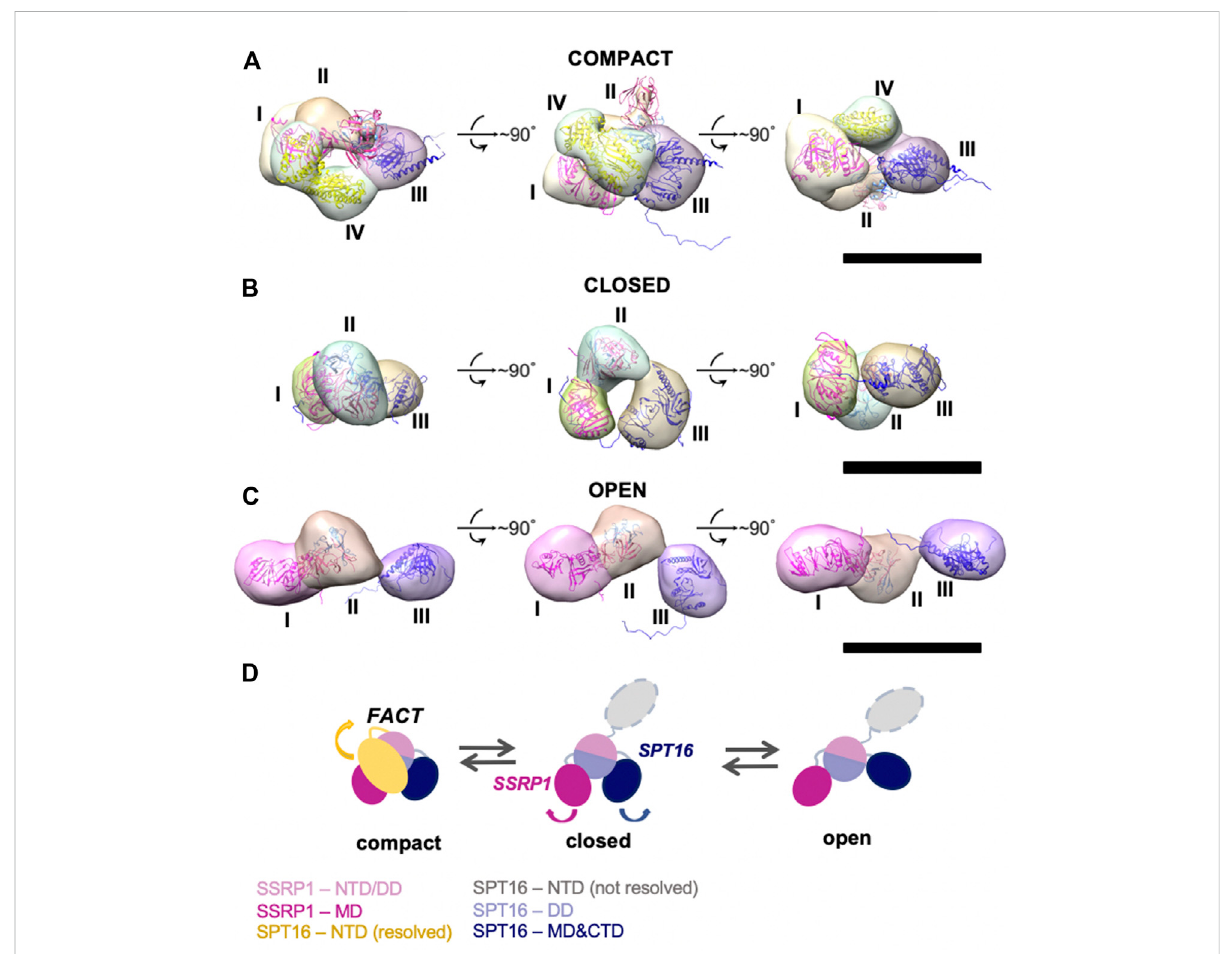
Three-dimensional reconstructions of FACT in compact, closed and open conformations. (A – C) 3D maps of FACT in the compact (A) , closed (B) and open (C) conformations. In the compact complex, the crystal structures of the domains were docked into corresponding EM densities I-IV withcorrelationcoef fi cientsof0.92;0.91;0.89;0.93,respectively.Bar — 10 nm (D) .TheproposedpathwayofFACTunfolding.Thecolorcodeforthe domains of FACT is shown at the bottom of the fi